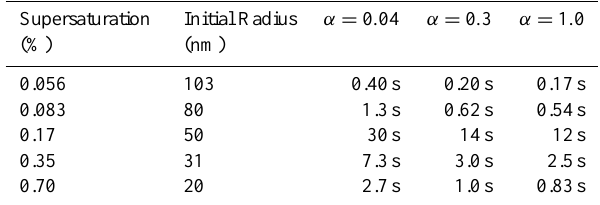
Table 2. The time for various bins to grow larger than 0.5µm to be detected at different supersaturations. Water accommodation coef- ficient α = 0 . 04, 0.3 and